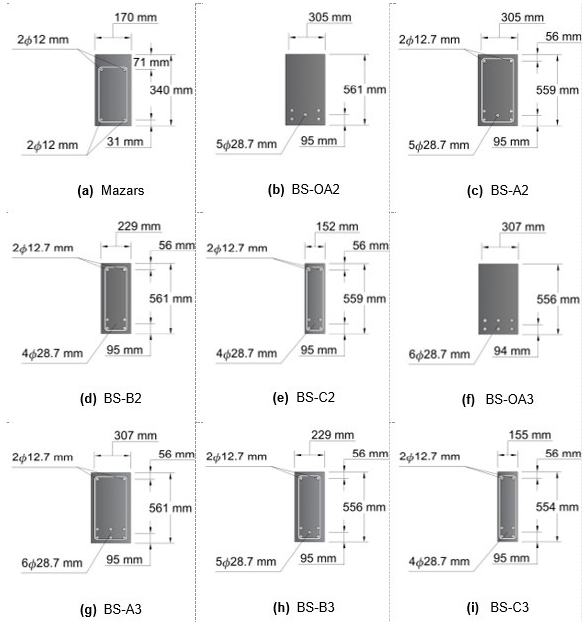
Figure 7. Cross-section